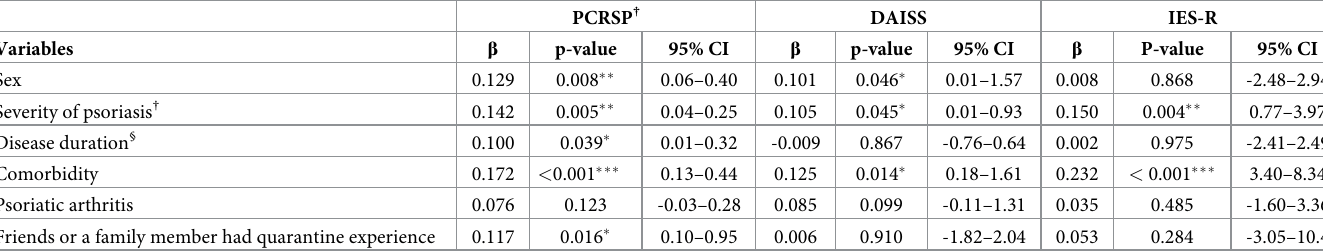
Table 2. Results of multiple linear regression on factors associated with PCRSP, DAISS, and